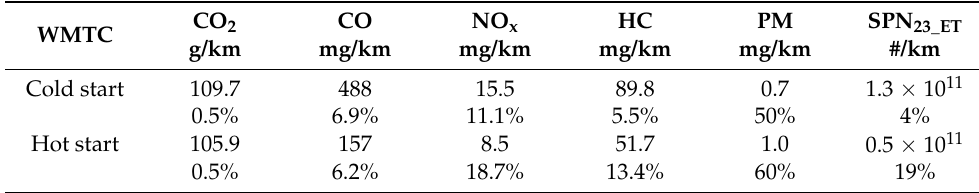
Table 5. Mean values and variance (as standard deviation of means, i.e., coefficient of variance) of the (four) measurements in 2017 and 2020 with the two laboratories. For PM and SPN 23 only two measurements were available (in 2020).